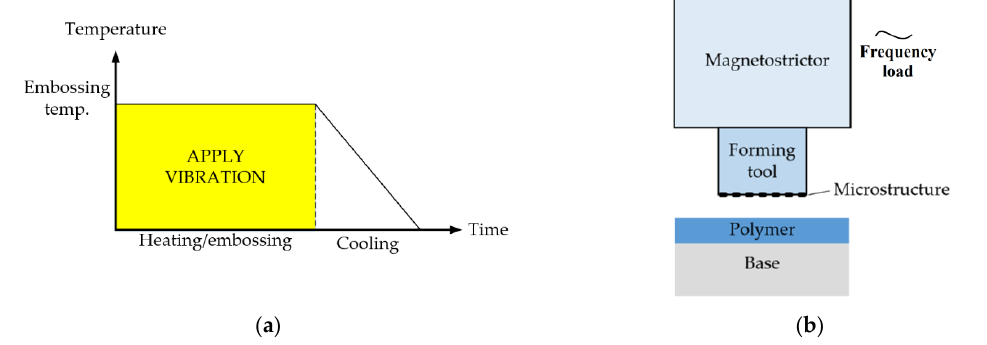
Figure 6. ( a ) Temperature curves for hot embossing procedures using a magnetostrictor; ( b ) Principle of operation of the magnetostrictor.